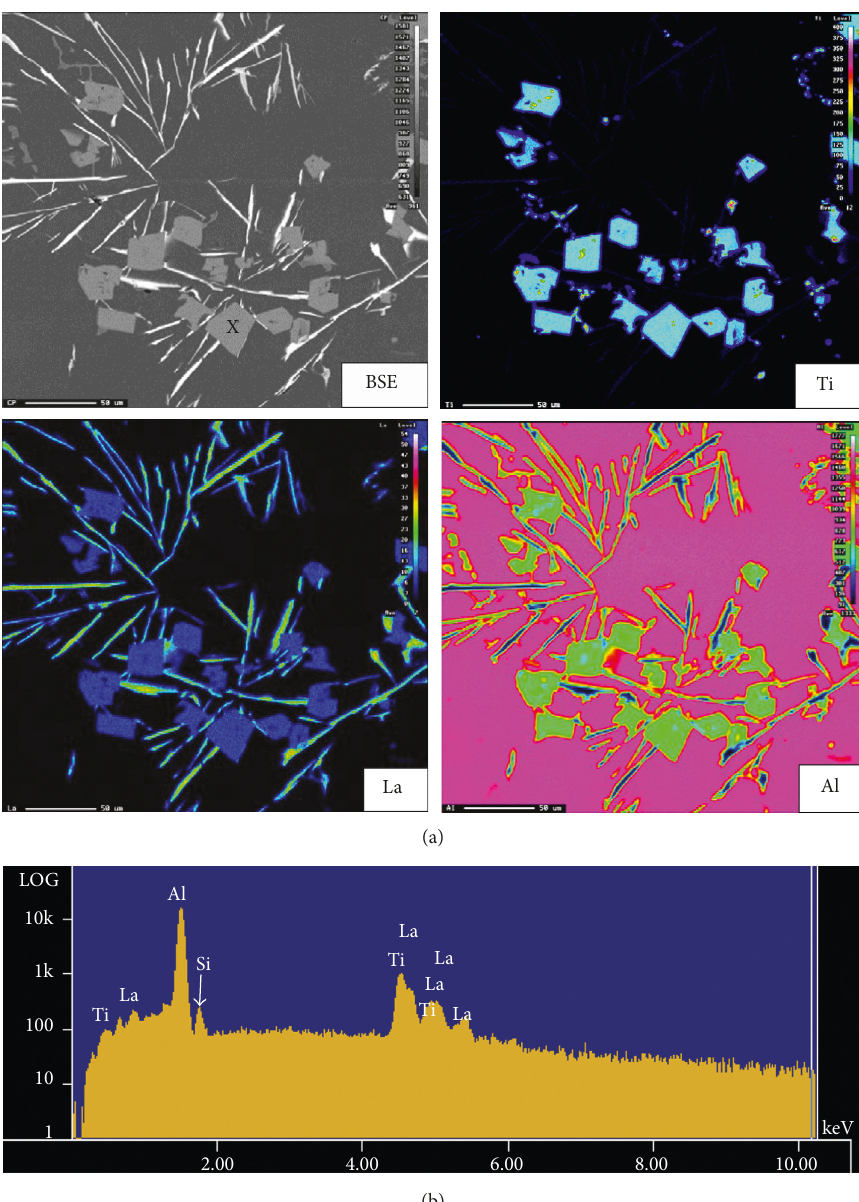
Figure 9: (a) Backscattered electron image and distribution of Ti, La, and Al in D0 +La +Ti alloy and (b) EDS spectrum corresponding to the gray phase marked X in